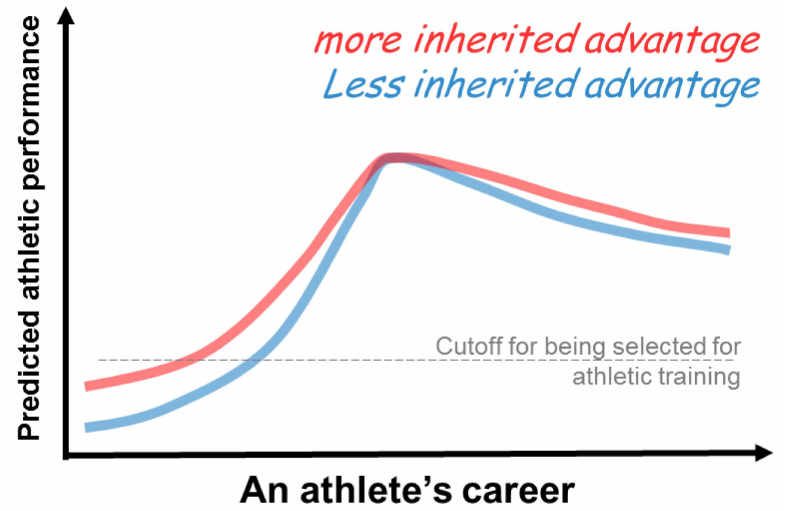
Figure 3. A hypothetical plot for athletic performance over an athlete’s career span. The footing for those that inherited more sports talent (red line) is deemed higher than the footing for those with less sports talent (blue line). If there is no external interference throughout, the difference between the red and blue curves is expected to be smaller at the peaks. Conceivably, one with less talent would need to put in more effort to reach one’s peak level, as demonstrated by the steeper upward slope of the blue curve compared to the slope of the red